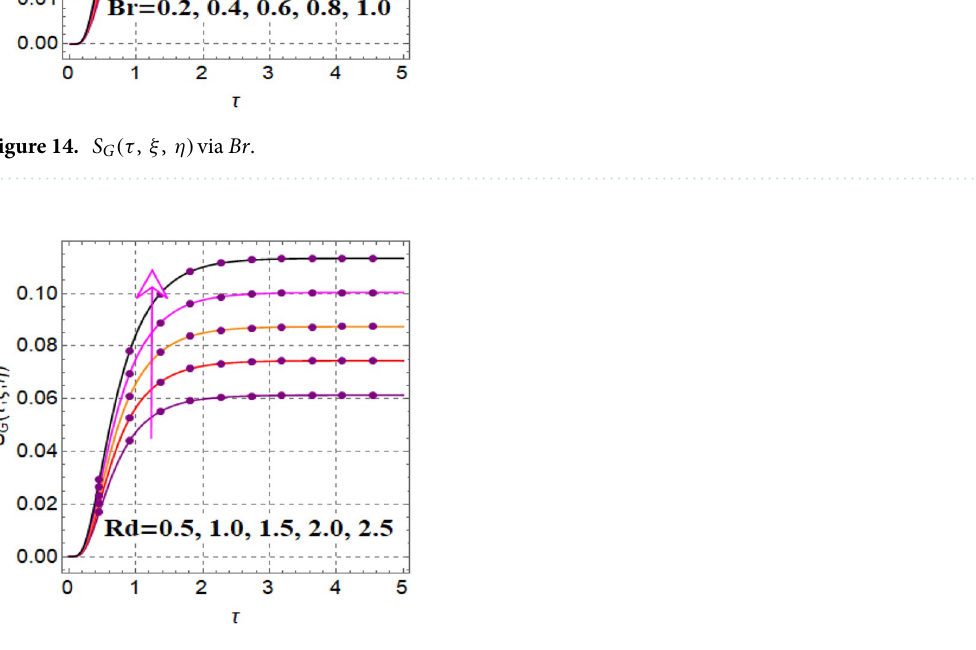
Figure 15. S G (τ , ξ , η) via Rd